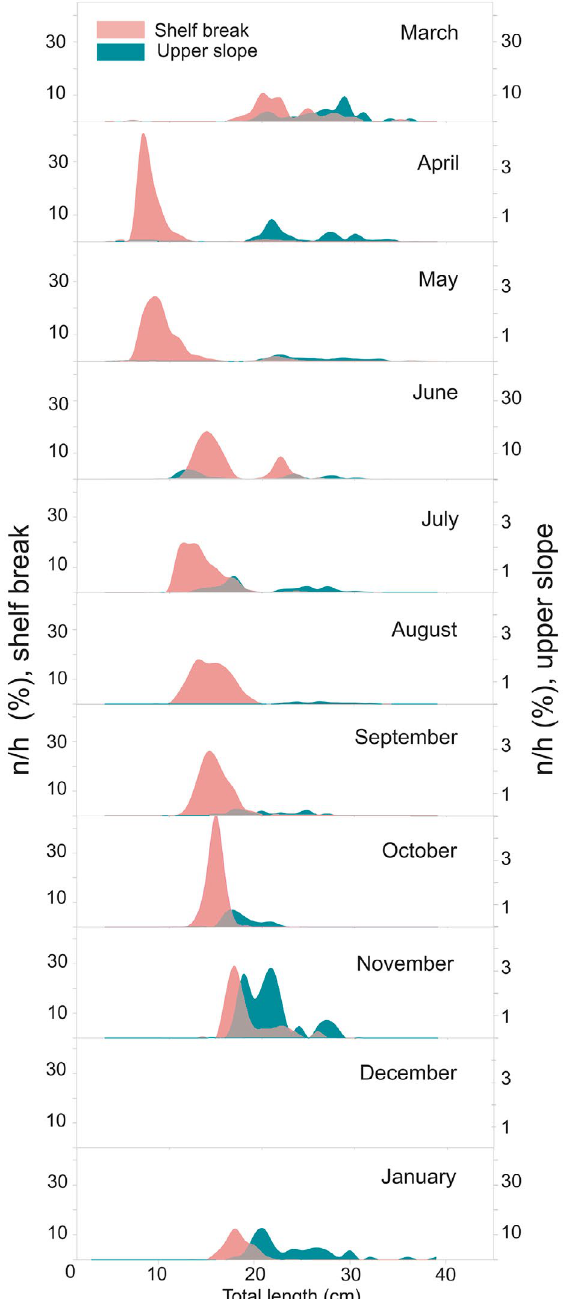
Fig. 5. − Monthly length frequency distributions of the total catch of blue whiting (commercial+discards) over the shelf break (pink) and upper slope (green) from March 2017 to January 2018, expressed in percentage. Note the different scale of the right axis in March, June and January. No data are available for December